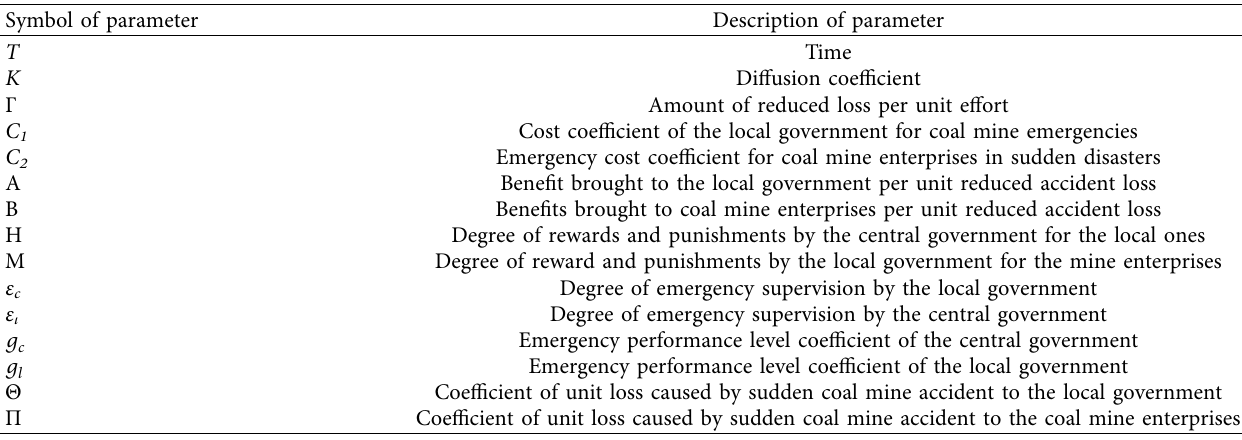
Table 1: Parameters of differential game models of the central government, the local government, and coal mine enterprises. Symbol of